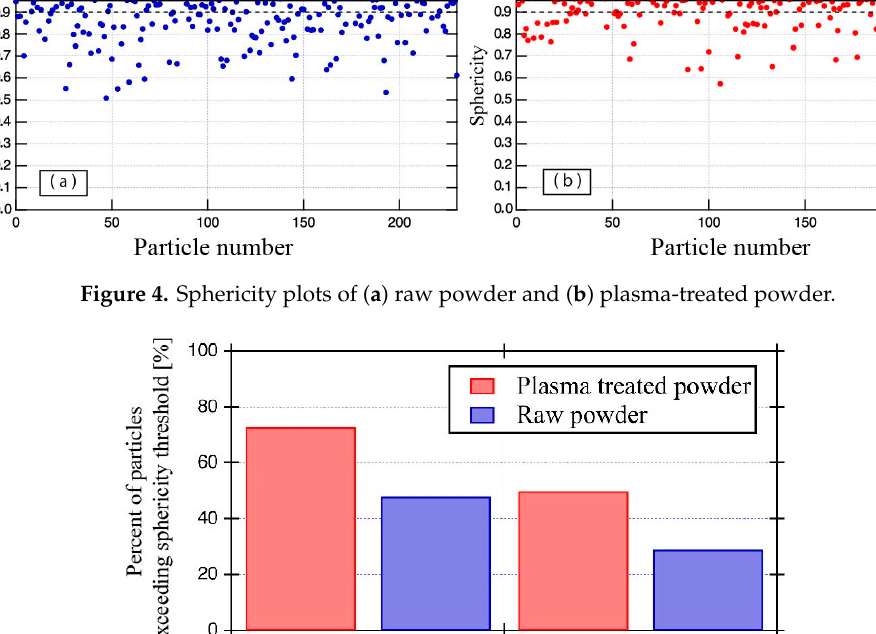
Figure 3. Particle size distributions of ( a ) raw powder and ( b ) plasma-treated powder.